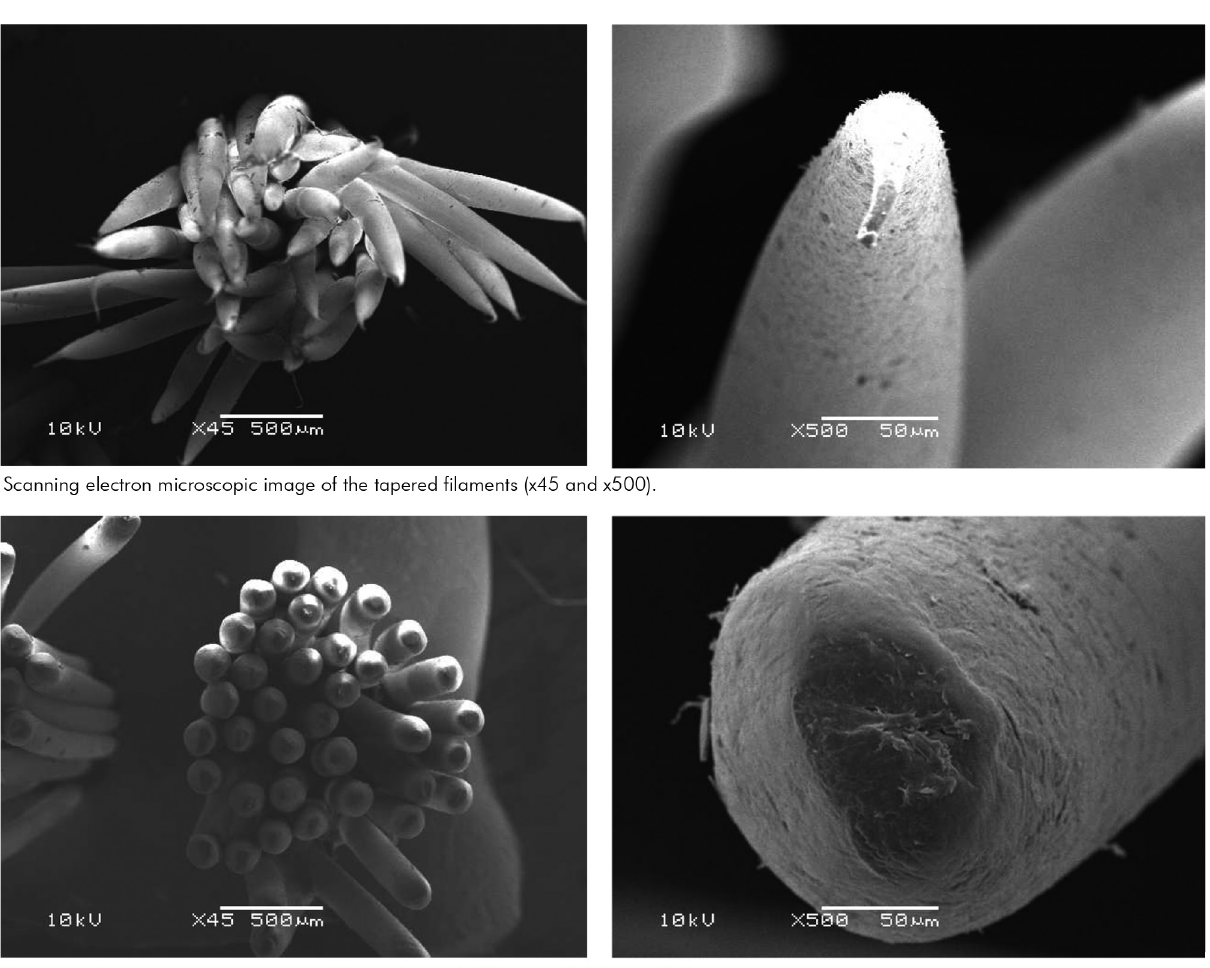
Figure 1. Toothbrush